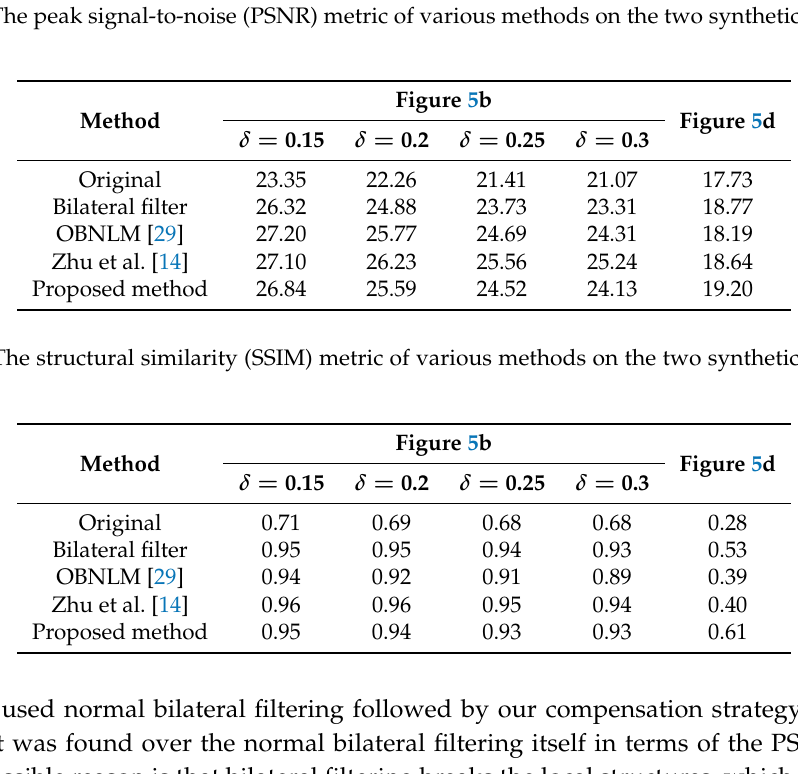
Table 1. The peak signal-to-noise (PSNR) metric of various methods on the two synthetic images in Figure 5. Figure 5b Method Figure 5d δ = 0.15 δ = 0.2 δ = 0.25 δ = 0.3